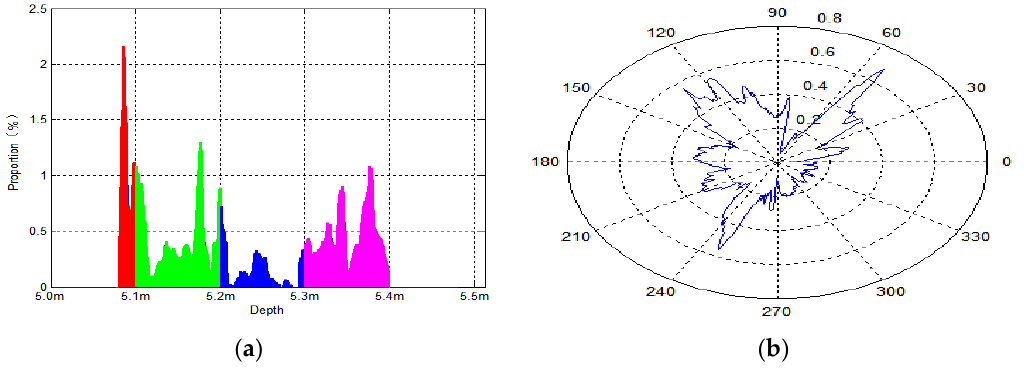
Figure 8. Area ratio projection: ( a ) depth direction and ( b ) circumferential direction.